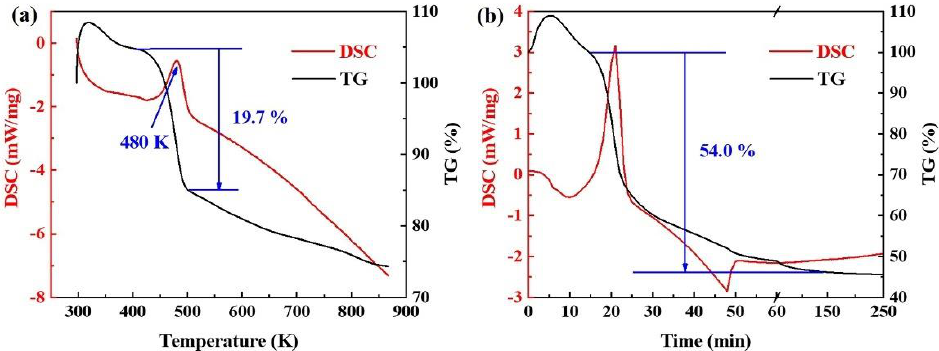
Figure 3. Differential scanning calorimetry of graphene oxide with ( a ) increasing temperature to 873 K and ( b ) increasing to 773 K and holding for 2 h.